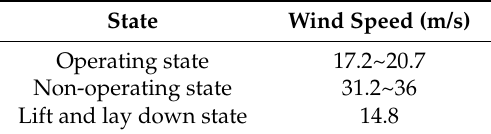
Table 3. Maximum wind speed of derrick in different working